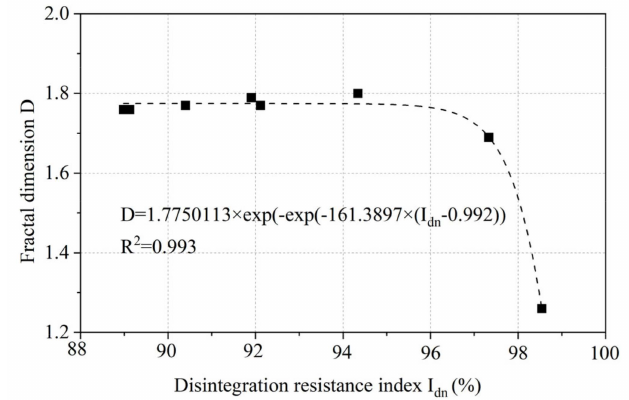
Figure 18. The correlation between disintegration fractal dimension D and disintegration resistance index I dn for sample #3.